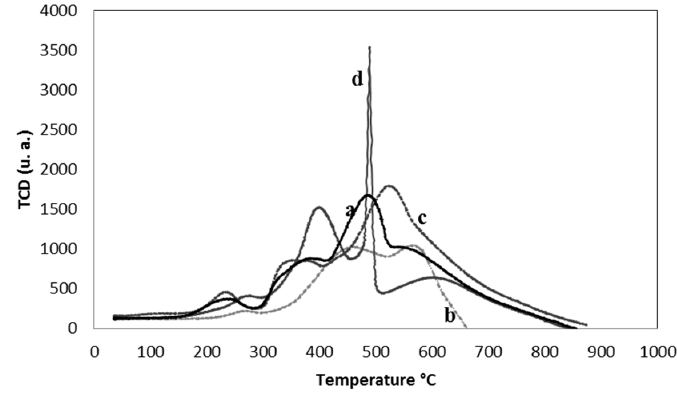
Figure 6. H 2 -TPR profiles of Catalyst. ( a ) Co 3 O 4 /G60; ( b ) Co 3 O 4 /CNR; ( c ) Co 3 O 4 /RB3; and, ( d ) Co 3 O 4 /RX3. Table 3. Metal loading, BET surface area, H 2 -TPR and XPS results of the catalysts. Catalyst